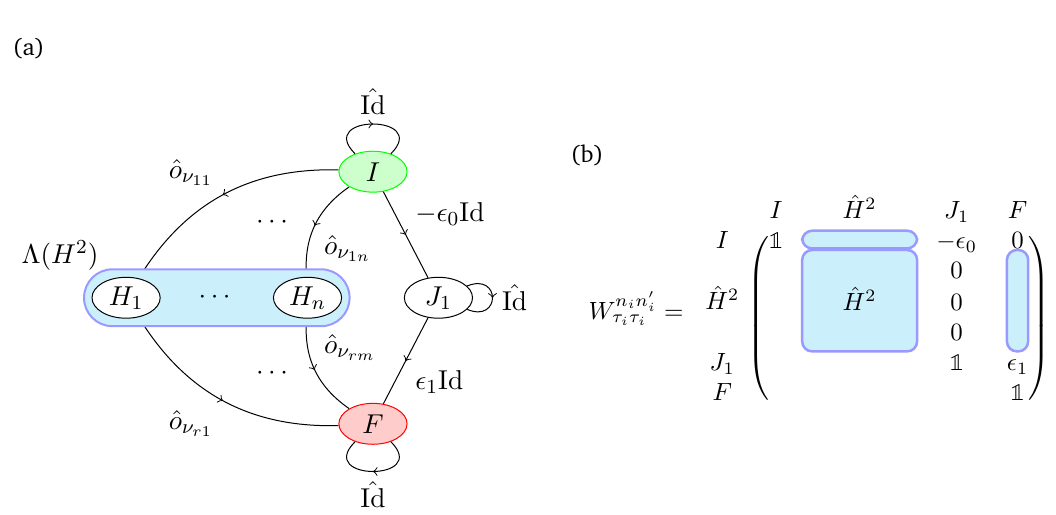
( var ( ˆ H )) , compare eq. (39). The representation of ˆ H 2 Figure 8: (a) Graph representation Λ 1 and of 〈 ˆ H 〉 2 are considered independently: For the former, we depict transitions from the initial state to the subgraph Λ ( ˆ H 2 ) and then to the final state indicated by the operators ˆ o represents the graph of ˆ H 2 ). For the latter, we depict transitions from the initial state to the state J of the FSM, and then to the final state via identity operators. Those identities carry 1 the weights − ε and ε , respectively, which after performing the multiplication yields −〈 ˆ H 〉 2 , 0 1 see eq. (39). (b) MPO site tensor obtained from the graph representation Λ entries with blue background denote the entries obtained from the site-tensor representation of Λ ( ˆ H 2 )